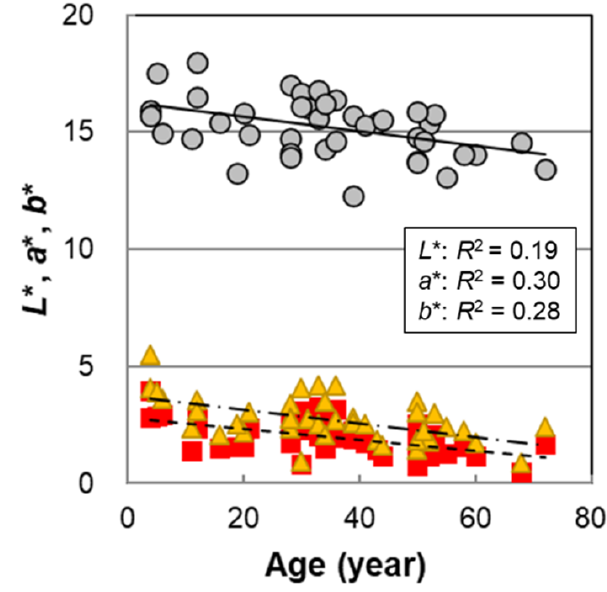
Figure 1. The age dependencies of hair color parameters L *, a *, and b * of Japanese male hair bundles. Circles denote L *; squares denote a *; and triangles denote b *. Lines represent the fitted curves. Solid line denotes L *; dashed line denotes a *; and dot-and-dash line denotes b *. p = 0.0035 ( L *), 9.6 × 10 − 5 ( a *), and 0.00020 ( b *).